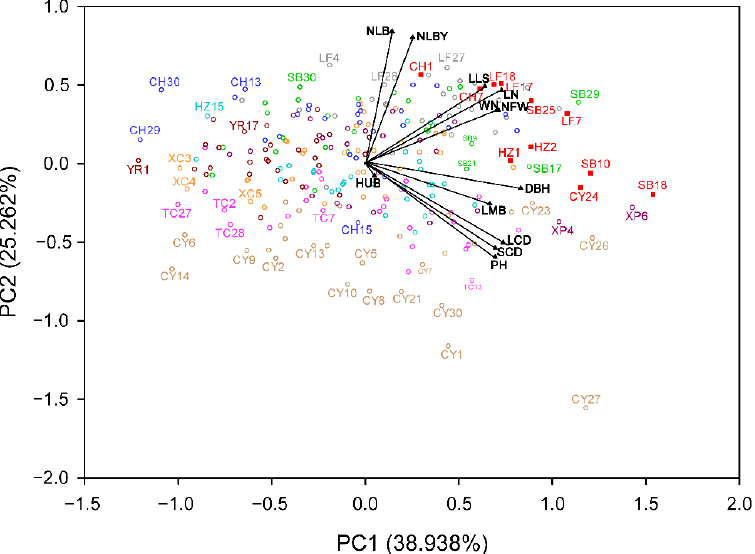
Figure 7. Ordination in the space of the first two principal component axes based on twelve phenotypic traits of 258 families of P. yunnanensis . The black solid triangle represents twelve different phenotypic traits. The red solid box represents the superior family selected while the black circle represents other families. Different populations were colored differently. Population abbreviations and phenotypic trait abbreviations are shown in Table 1 and Figure 2, respectively.